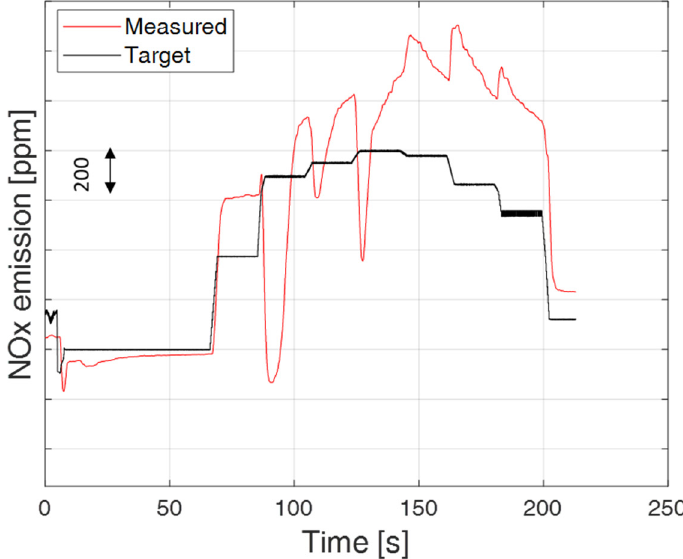
Figure 10. Actual and target values of the engine-out NOx emissions over ramp test 2 with an active EGR and nominal NOx target and with the combustion controller enabled.